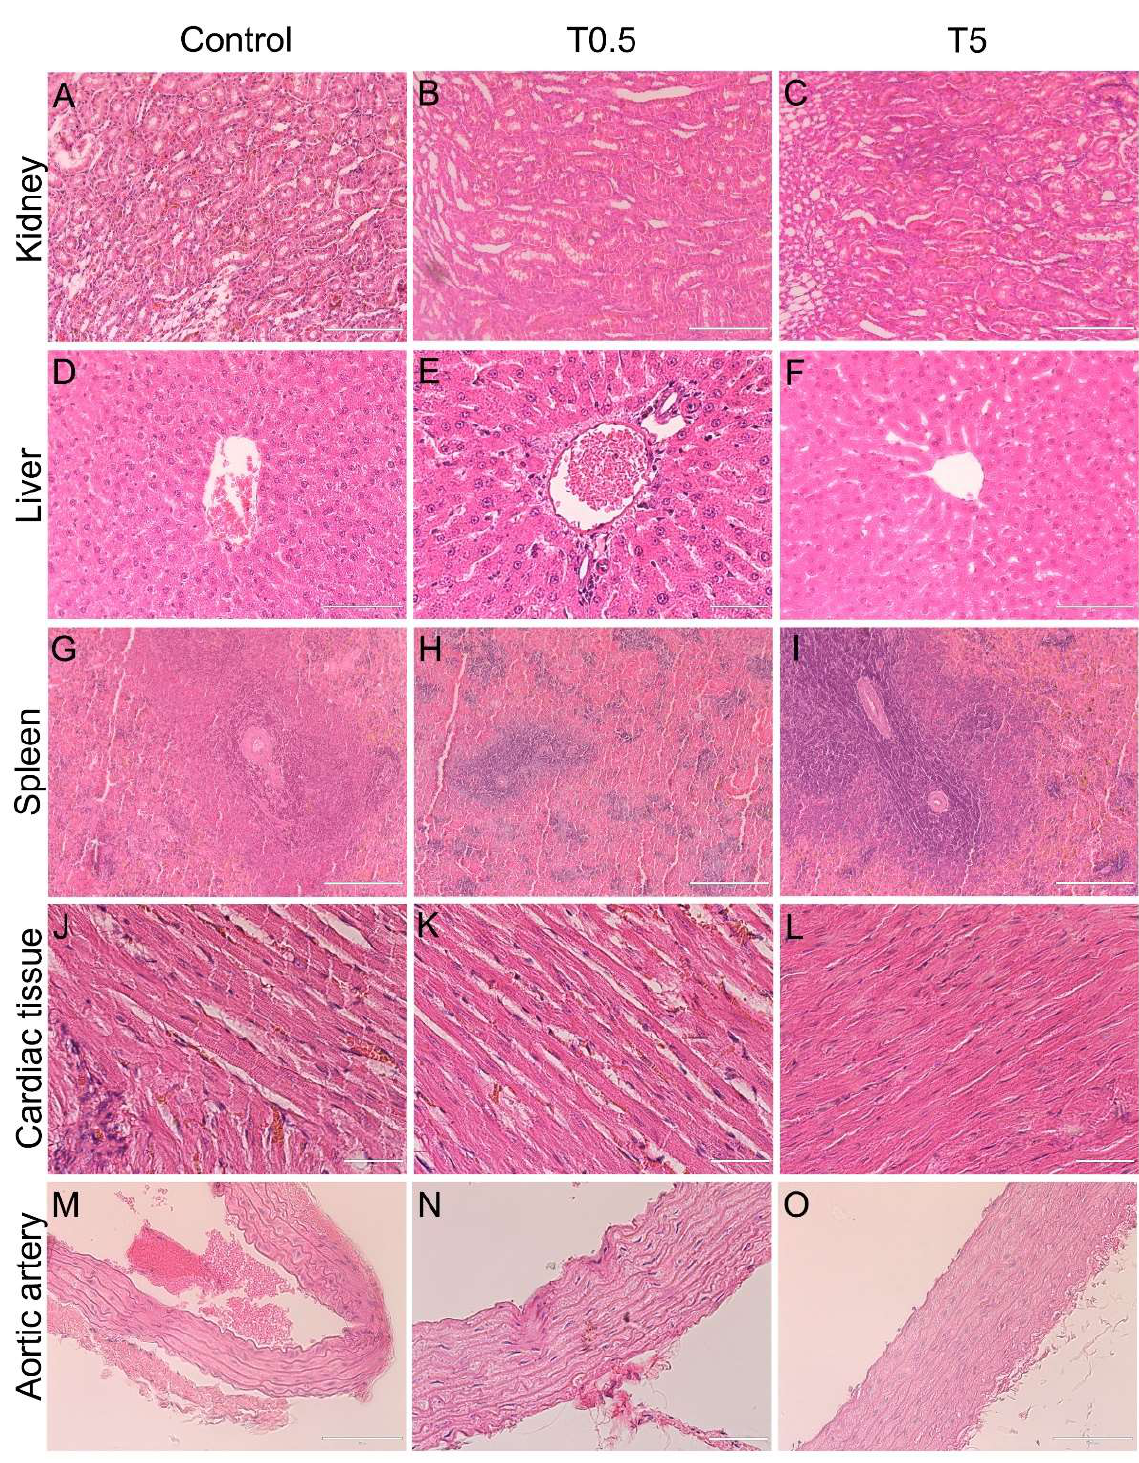
Figure 8. Representative micrographs of kidney, liver, spleen, cardiac tissue, and aortic artery in animals from the Control, T0.5, and T5 groups on Day 300 after the DMSA-MNP injection. All organs showed normal histological appearance. ( A – C ) Kidney (magnification 20 × , scale bar = 200 µ m), ( D – F ), liver ( D , F )—40 × magnification, scale bar = 100 µ m; ( E )—60 × magnification, scale bar = 50 µ m), ( G – I ) spleen (20 × magnification; scale bar = 200 µ m), ( J – L ) cardiac tissue (60 × magnification; scale bar = 50 µ m), and ( M – O ) aortic artery wall ( M , O )—40 × magnification, scale bar = 100 µ m; ( N )—60 × magnification, scale bar = 50 µm).